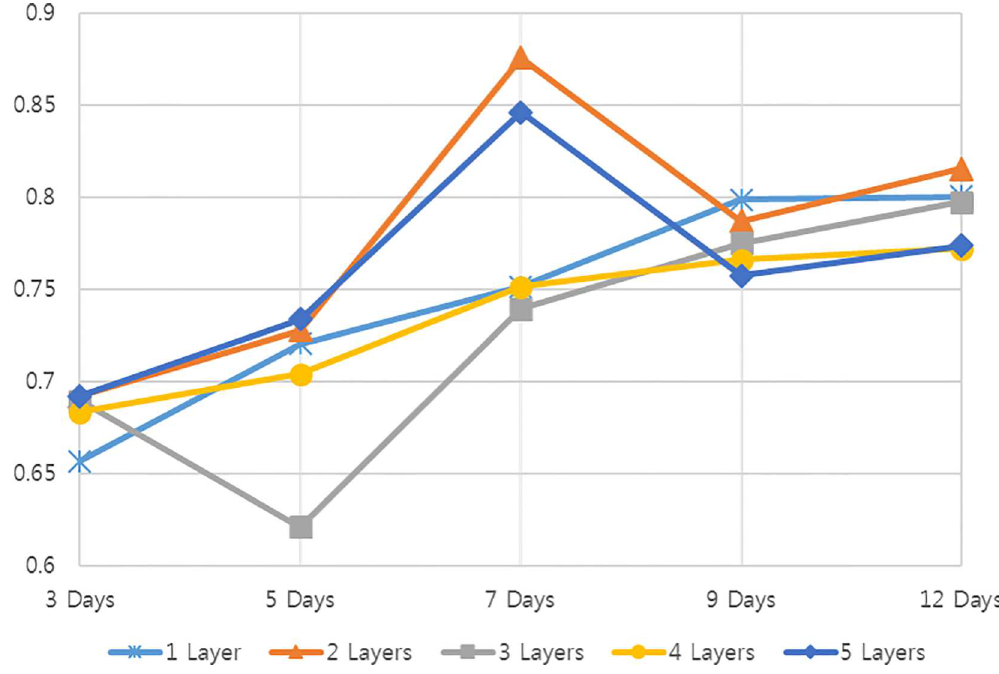
Fig 3. Experimental results. Valuesby data and layers